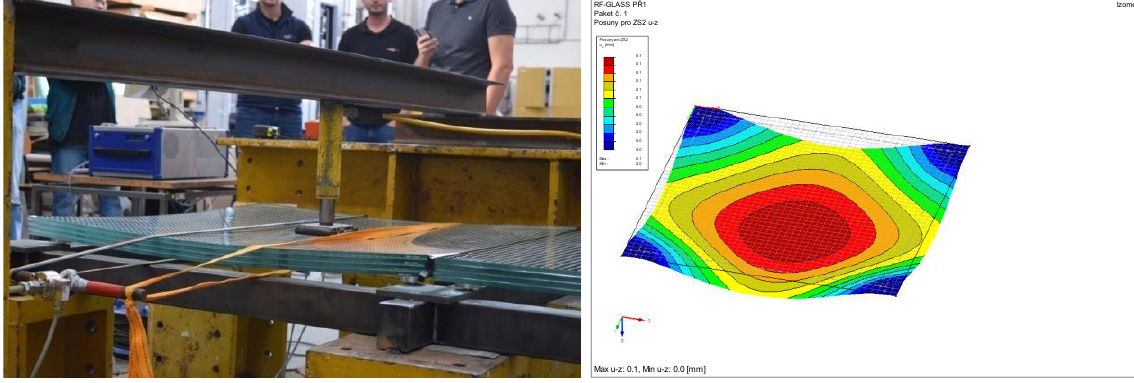
Fig. 9 a, b Measured visible vertical deformation of the glass pane.